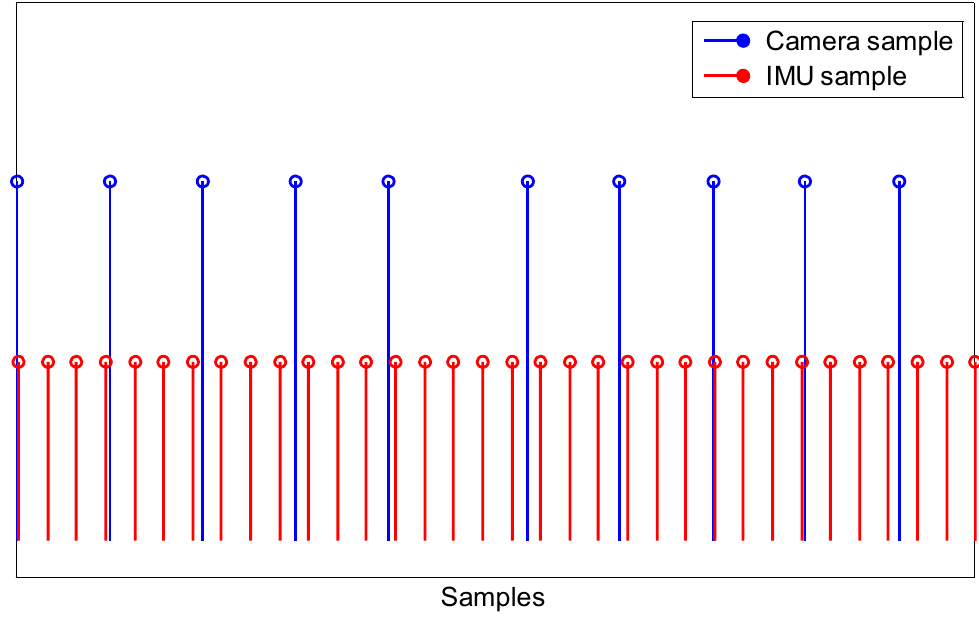
Figure 4. Timestamps of camera (blue) and IMU (red) samples. The number of IMU samples between successive image frames is slightly variable due to the irregular sampling rate of the